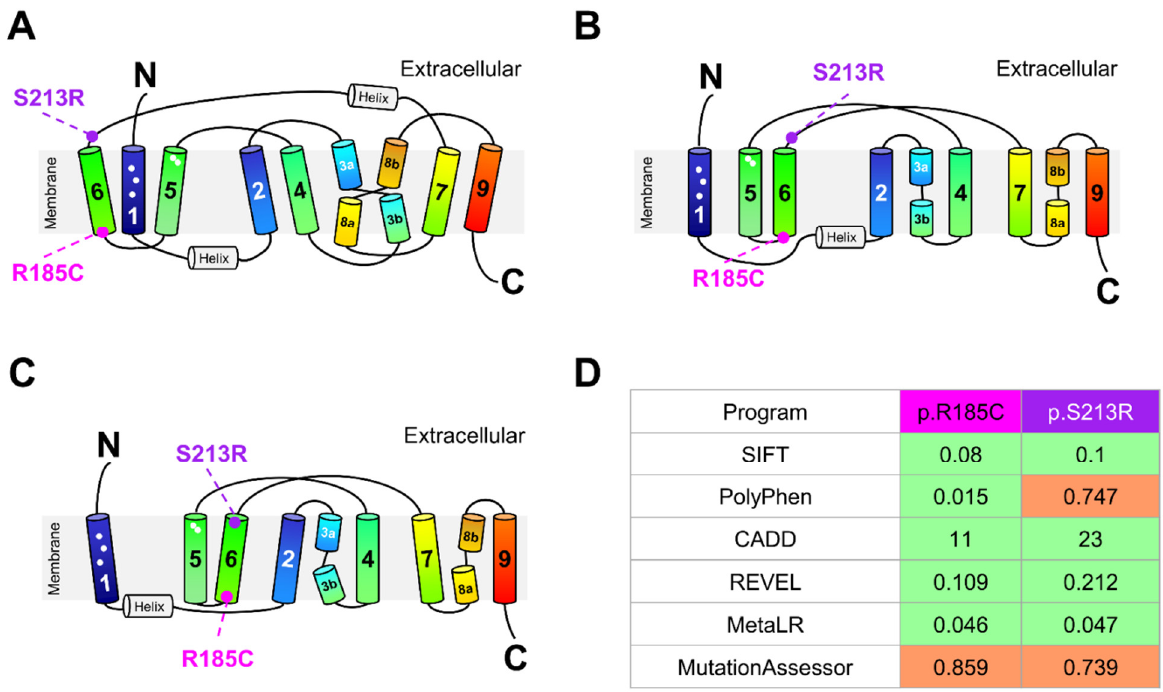
Figure 2. In silico analysis of NTCP missense variants. ( A – C ) Location of p.R185 and p.S213 in the three recently reported human NTCP structures. In all three structures, p.R185 is located at the start of the transmembrane segment (TM) 6. Amino acid S213 is located extracellularly in the topological models reported by ( A ) Goutam et al. [47] and ( B ) Asami et al. [46]. In the model reported by ( C ) Park et al. [48], this amino acid is located at the end of TM6. Putative conserved residues in the Na + -binding sites are located in TM2 (p.Q68), TM3b (p.S105/p.N106), TM4 (p.T123), and TM8a (p.E257, p.Q261); key residues for bile acid-binding are in TM1 (p.L27, p.L31, p.L35) and in TM5 (p.K157, p.G158) [48] and their approximate locations are indicated by white circles. TM1, TM5, and TM6 form the “panel domain” whereas the other TMs form the “core domain”. ( D ) Predicted functional consequences of p.R185C and p.S213R as obtained from Ensembl Release 106 (https://www.en-